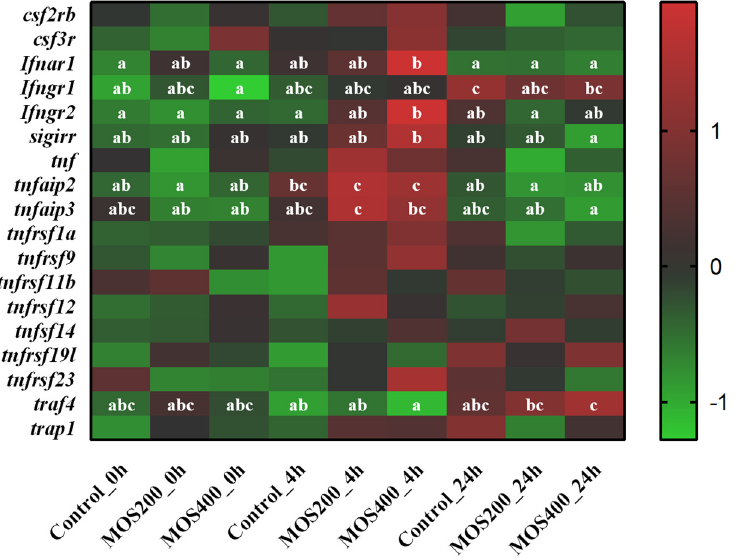
Figure 5. Heatmap of pro-inflammatory cytokines based on DGE profiling. The color values repre- sented up-regulated (red) and down-regulated (green) expressions of selected DEGs, which ranged from 1 to − 1. Different alphabets indicate statistically significant differences after performing Tukey’s HSD test ( p < 0.05).